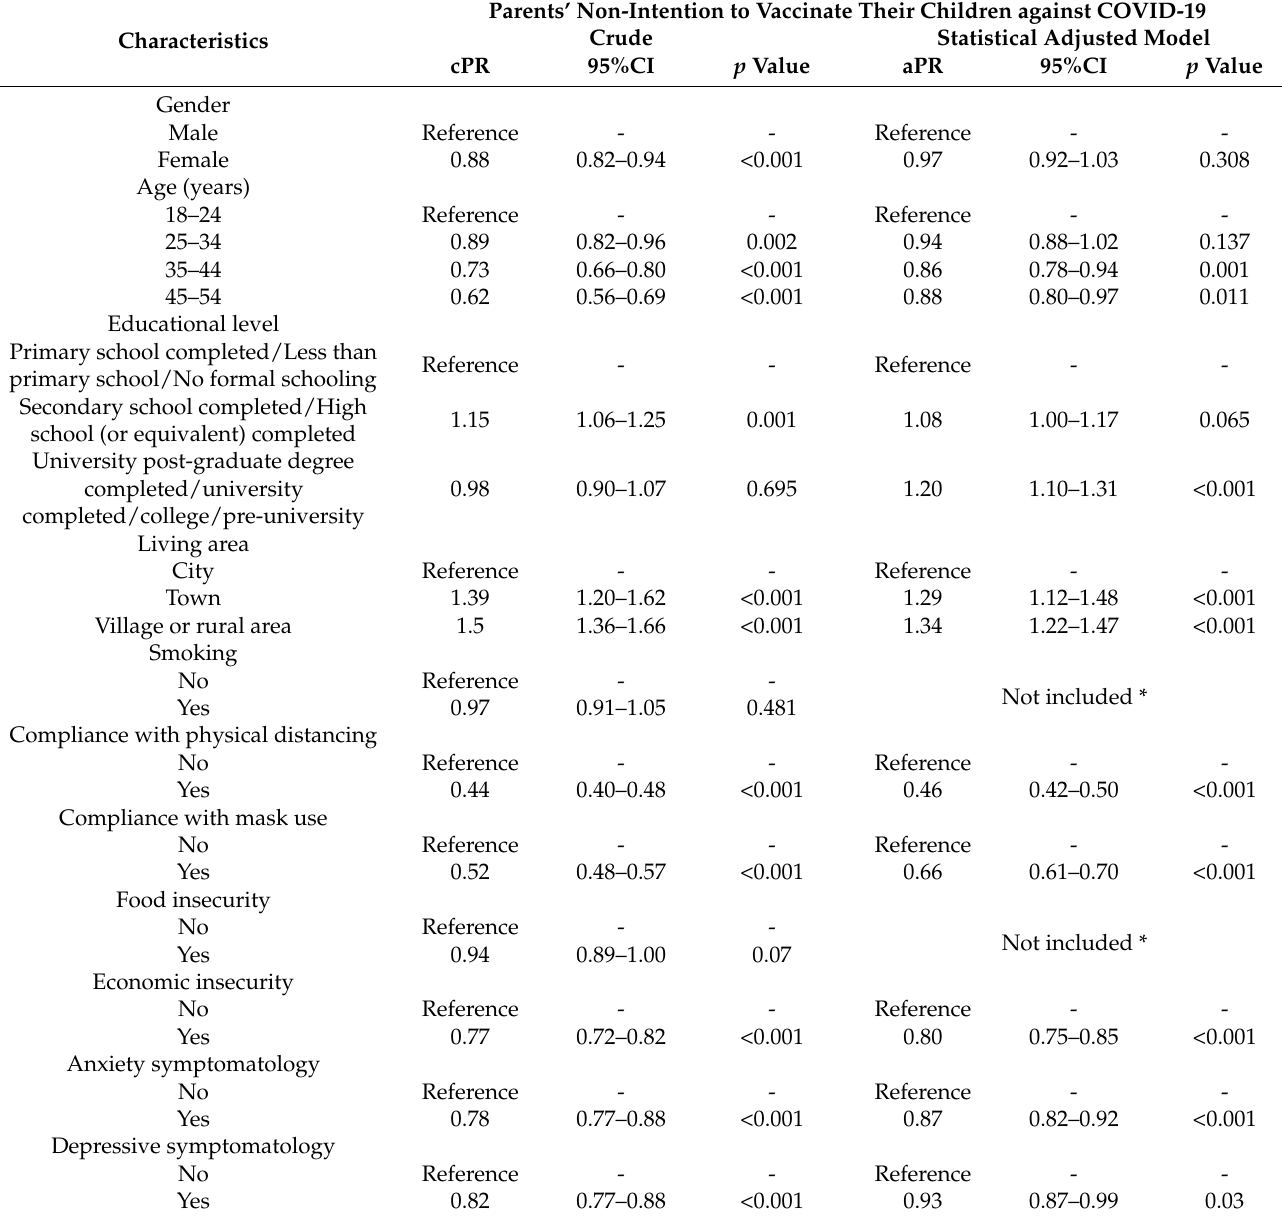
Table 3. Factors associated with parents’ non-intention to vaccinate their children against COVID-19.